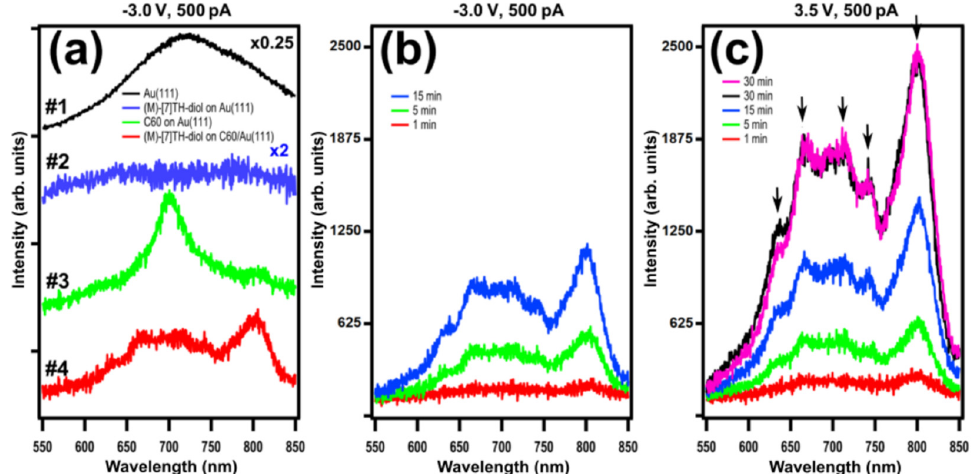
Figure 5. ( a ) STM-LE spectra taken on: Au(111) surface (#1), (M)-[7]TH-diol molecules adsorbed on Au(111) surface (#2), C 60 layer grown on Au(111) (#3) surface and the multilayer of (M)-[7]TH-diol molecules adsorbed on C 60 layer grown on Au(111) surface (#4). All spectra were obtained under the same condition at the sample bias of − 3.0 V and tunneling current of 500 pA with acquisition time equal to 5 min. The spectra are vertically offset for visual clarity. ( b ) STM-LE spectra taken on the multilayer of (M)-[7]TH-diol molecules adsorbed on C 60 layer grown on Au(111) surface. All spectra were obtained at a sample bias of − 3.0 V and a tunneling current of 500 pA with different acquisition times. ( c ) STM-LE spectra taken on the multilayer of (M)-[7]TH-diol molecules adsorbed on C 60 layer grown on Au(111) surface. All spectra were obtained at a positive sample bias of 3.5 V and a tun- neling current of 500 pA with different acquisition times.